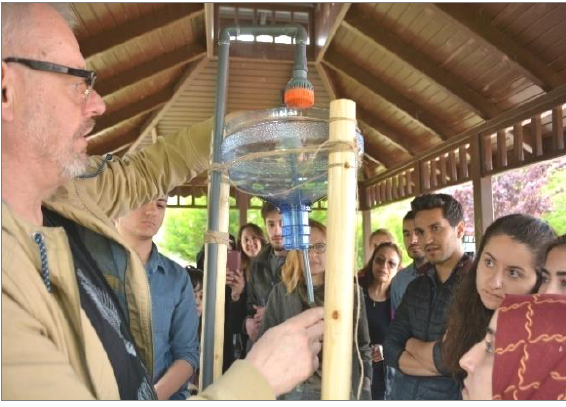
Figure 17 Aquaponic workshop before game-session on urban agriculture and food